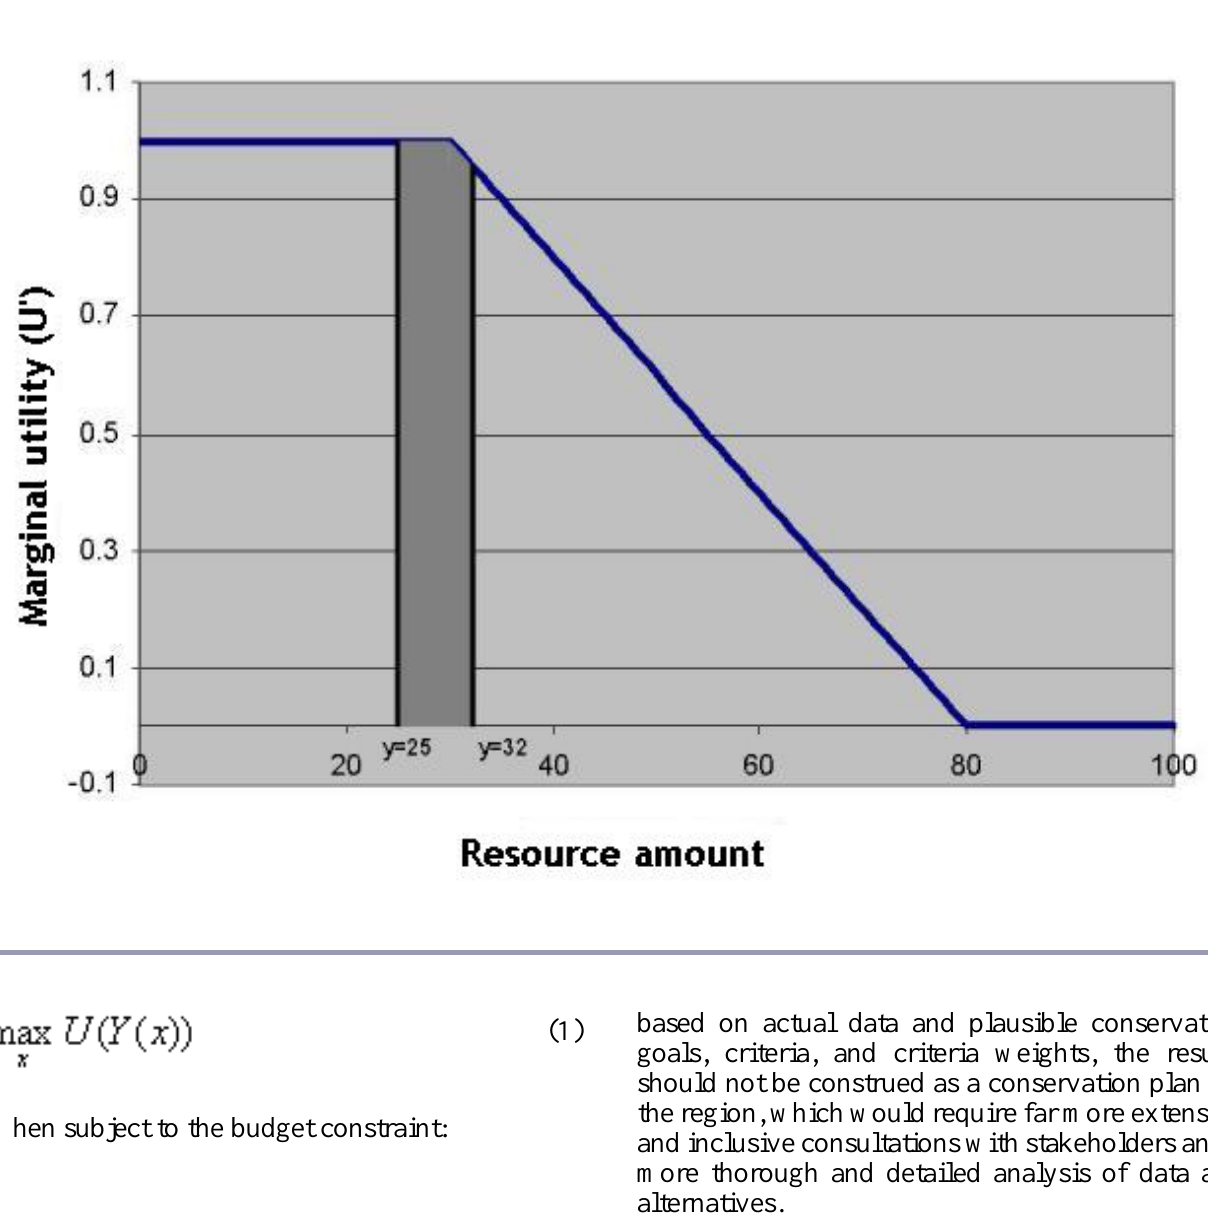
Fig. 2. Marginal utility function derived from the function in Fig.